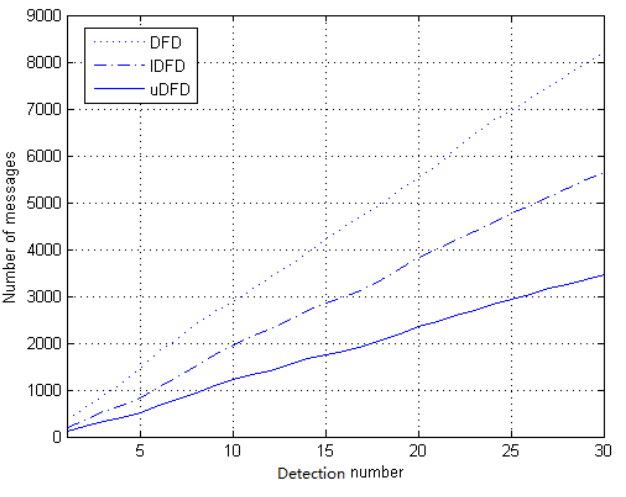
Figure 13. Energy consumption of each node under 40 working node